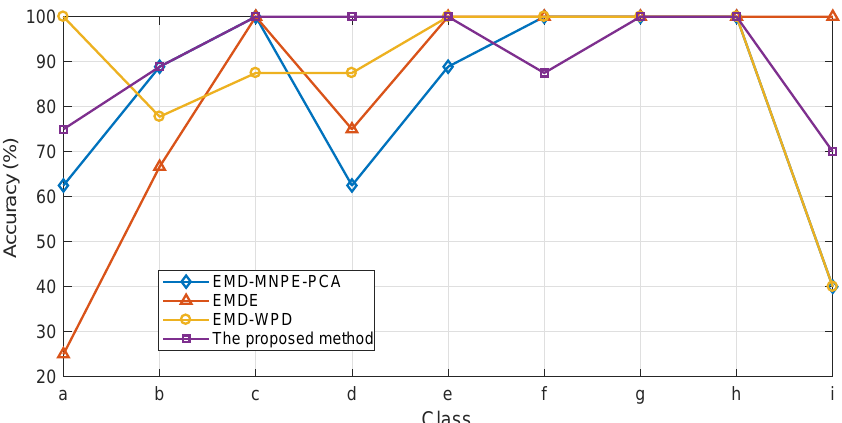
Figure 13. The identification accuracy of each class via IPSO-MSVM using different feature extraction methods. Table 3. The identification results via IPSO-MSVM using different feature extraction methods. Class of Number of Number of Correctly Identified